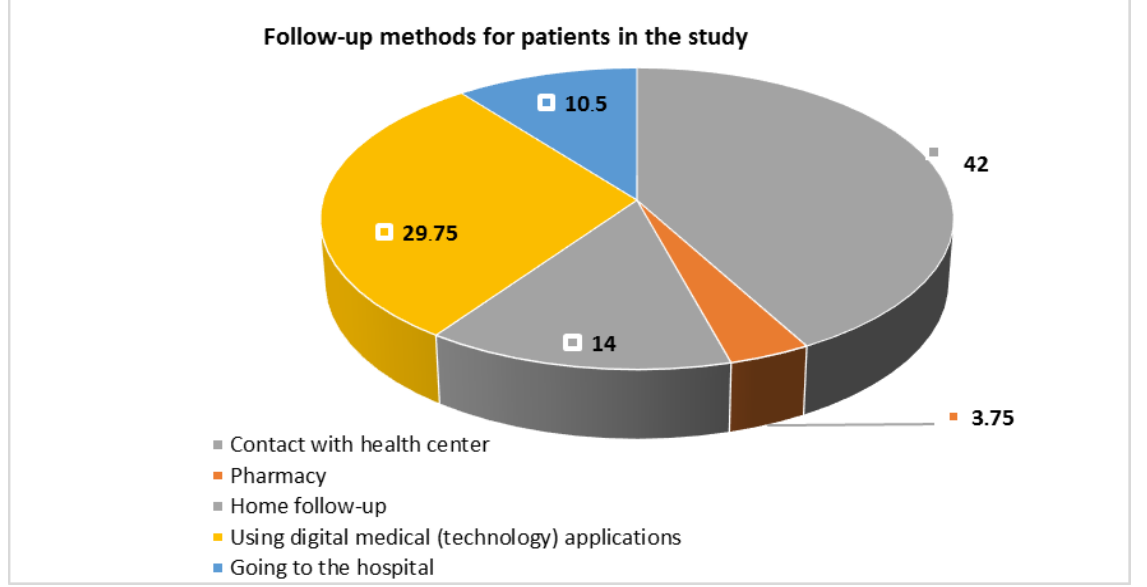
Figure 1. Percentage distribution of the follow-up methods for patients in the study.